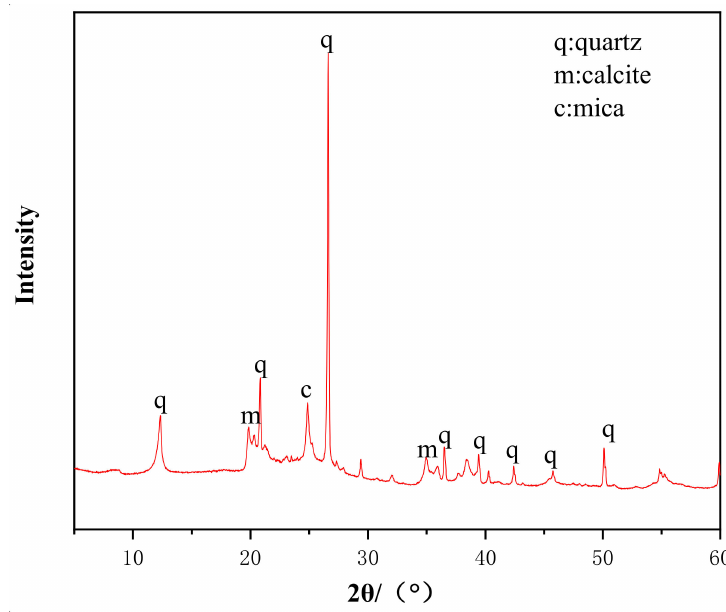
Figure 1. X-ray diffraction patterns of coal